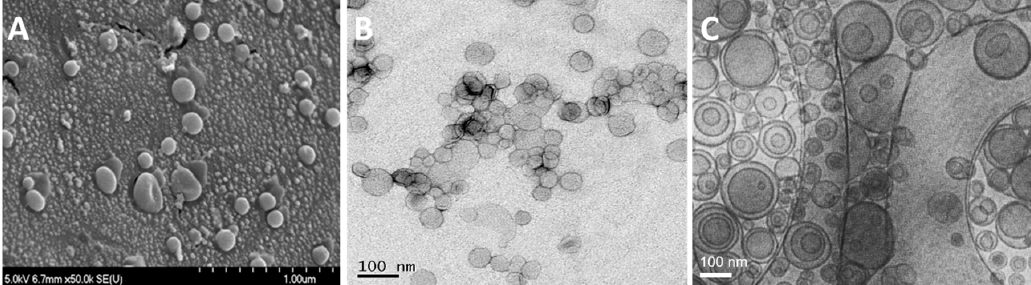
Figure 6. Morphology of the AmB-liposomes. ( A ) Freeze fracture electron micrographs; negative-stain transmission electron micrographs of liposomes prepared by the ( B ) SCF-CO 2 method, ( C ) conventional method.